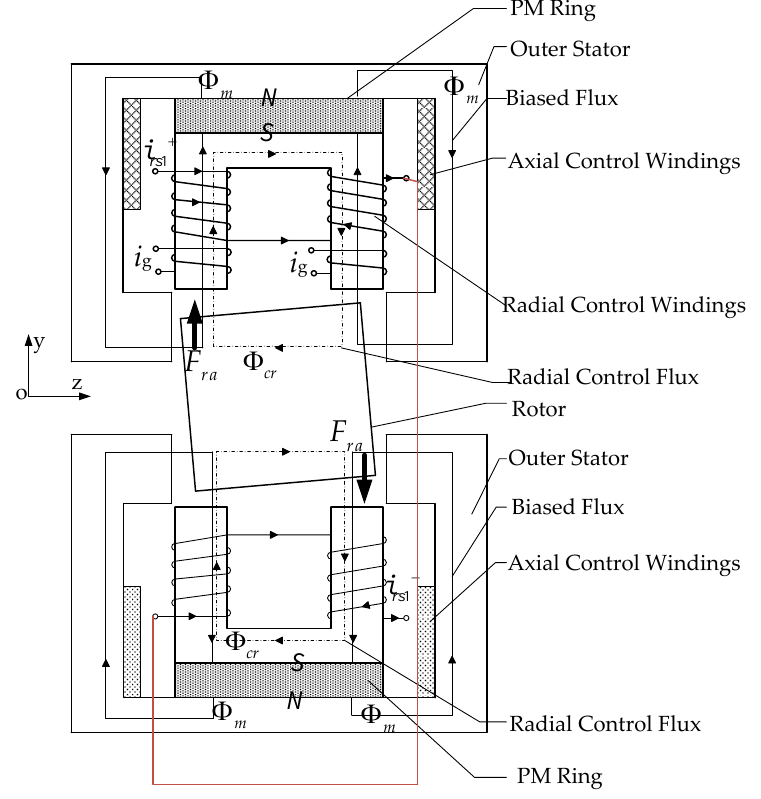
Figure 3. Principle of radial suspension force generation.